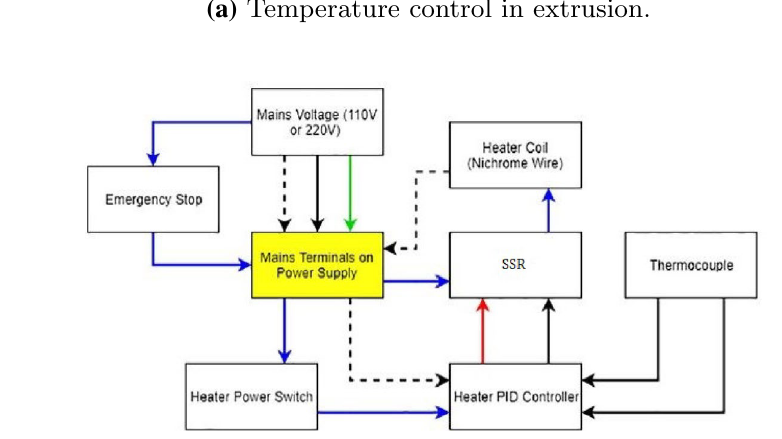
(a) Temperature control in extrusion.